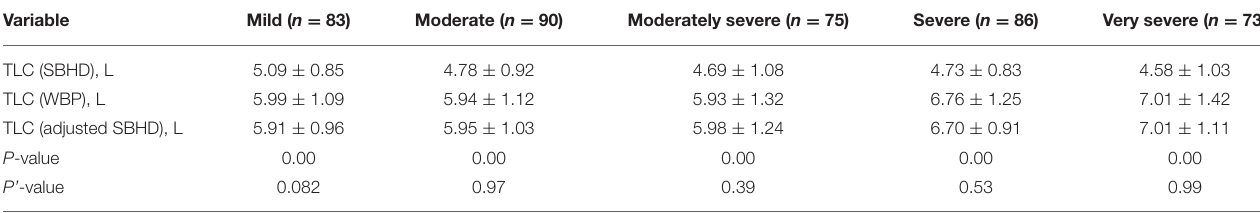
TABLE 3 | Differences (mean ± standard deviation) in TLC in the training group of subjects stratified by airflow limitation severity. Variable